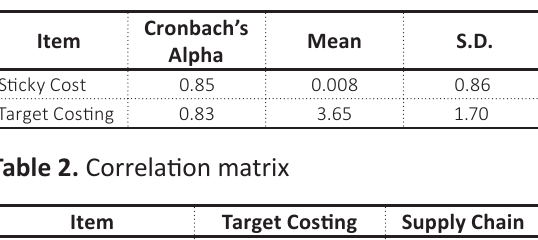
Table 1. Cronbach’s alpha